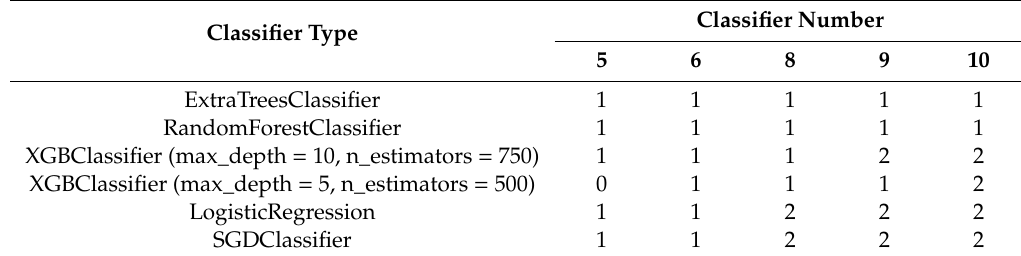
Table 14. Selection of the number and combination of di ff erent classifiers.